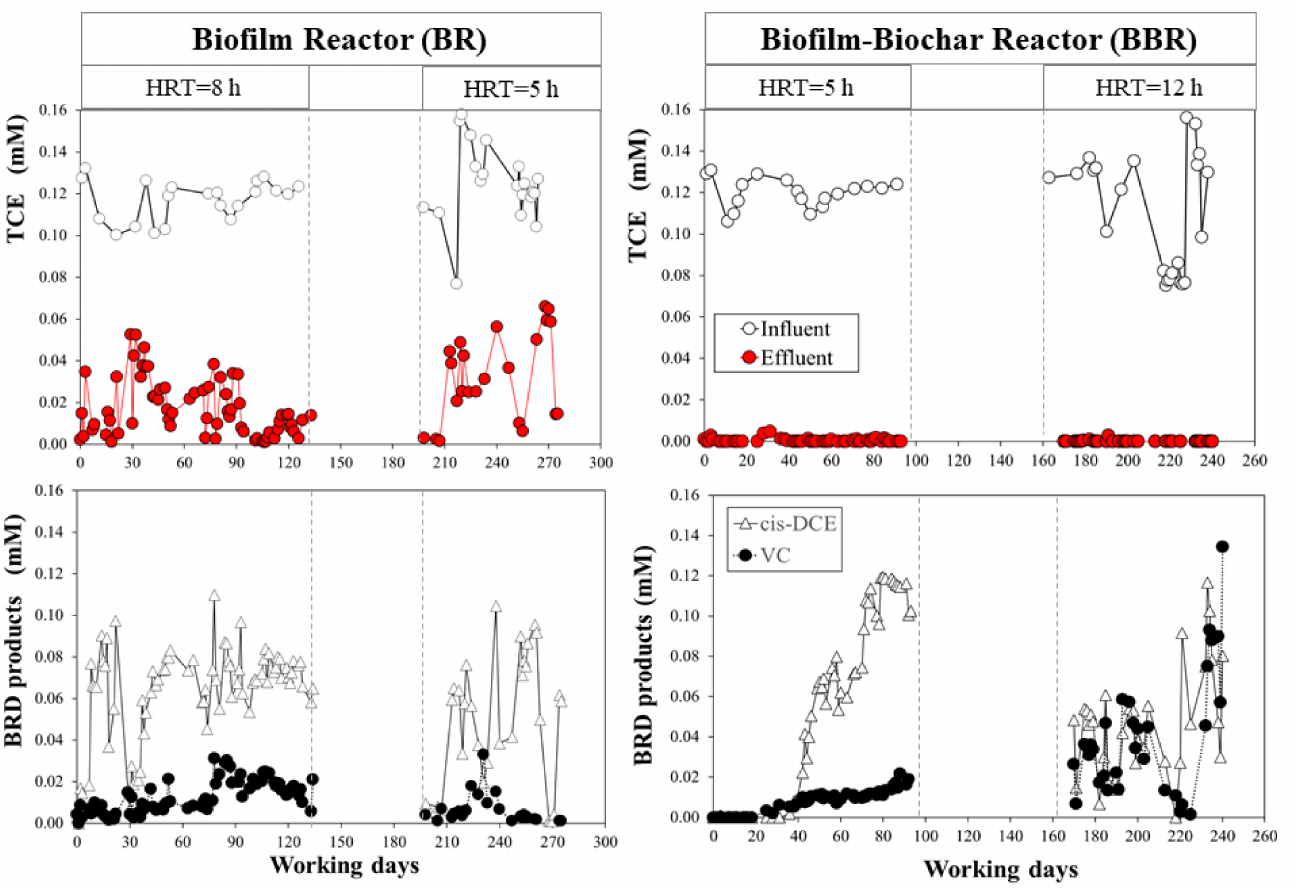
Figure 4. Reactor monitoring. The interruption period corresponds to the suspension of activities due to the COVID-19 health emergency in the city of